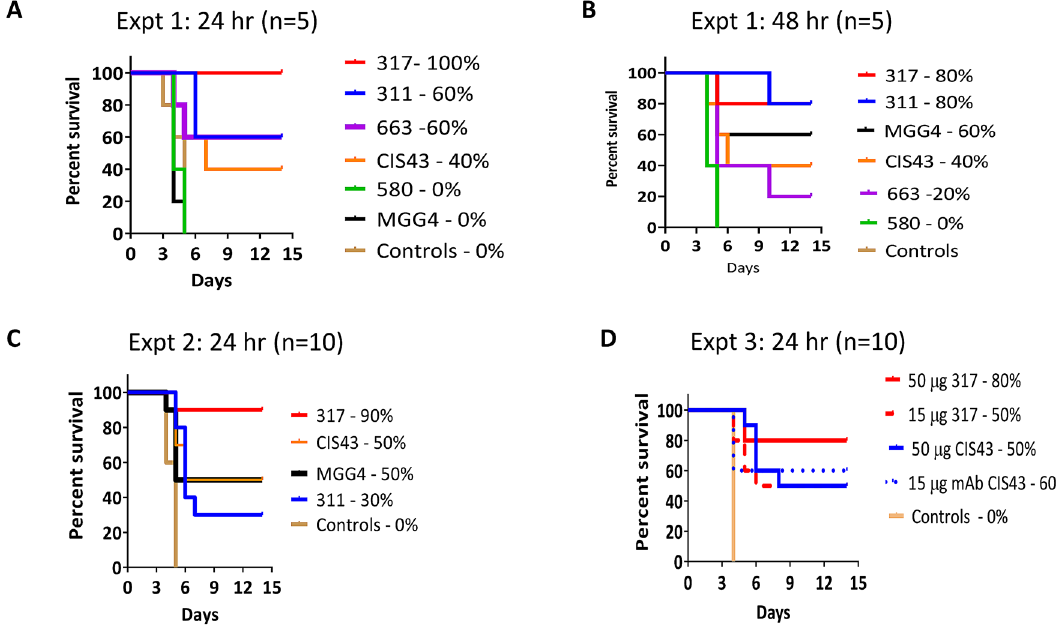
Figure 7. In vivo protection experiments. MAbs were passively transferred (i.v.) into mice followed by i.v. challenge with 1000 transgenic P. berghei-falciparum sporozoites. Survival curves and sterile protection outcomes at day-14 post challenge as determined by the absence of blood stage parasitaemia. ( A ) Experiment 1 (100 µg each mAb; n = 5 per group) challenge at 24 h post transfer; ( B ) 48 h post challenge. ( C ) Experiment 2 (100 µg mAb; n = 10) challenge at 24 h post mAb transfer. ( D ) Experiment 3 using mAb 317 and CIS43 (50 and 15 µg dose; n = 10), challenge at 24 h post mAb